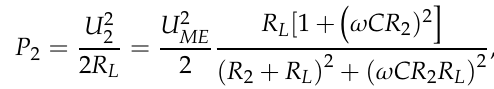
Figure 7. Simplified equivalent circuit of the output capacitive part of the ME transformer. U ME is the open-circuit magnetoelectric voltage; R 2 is the output resistance of the transformer, C is the output capacitance of the transformer, both connected in parallel; R L is the load resistance; U 2 is the measured voltage at the load resistor R L .